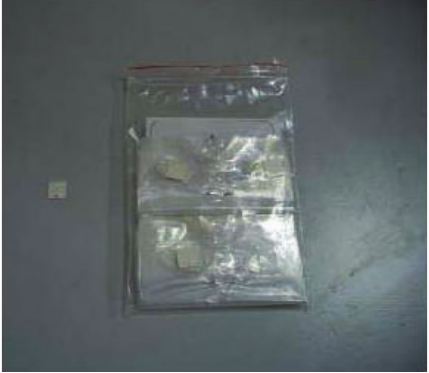
Figure 1: Naked PZT patches.